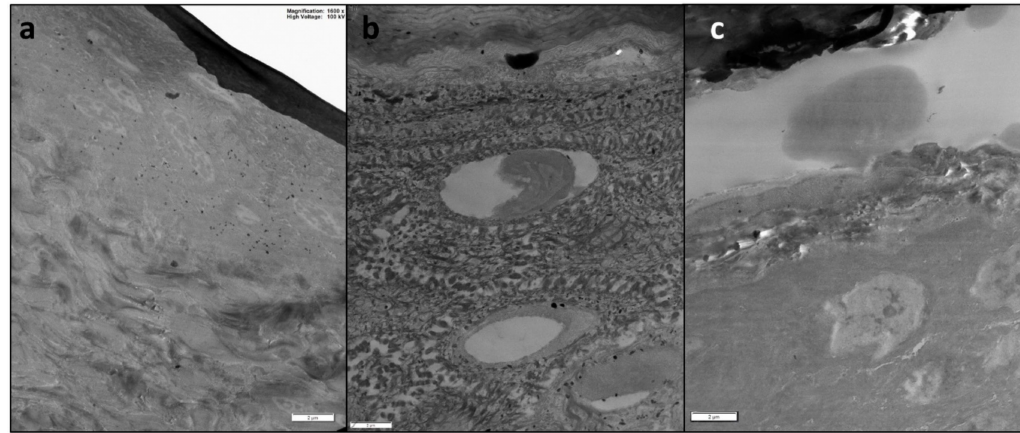
Figure 5. Representative TEM micrographs of skin samples treated with CeO 2 NPs: ( a ) blank cell; ( b ) intact skin; and ( c ) damaged skin. Bar = 2 µ